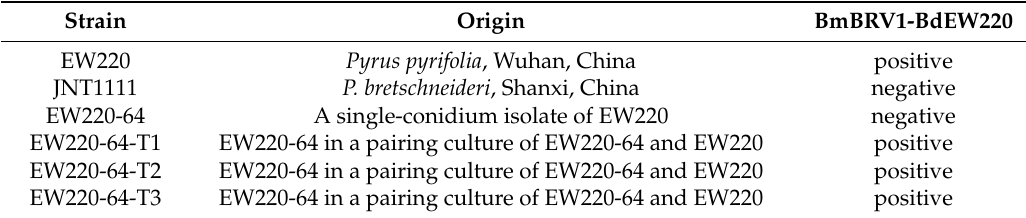
Table 1. Origin of the strains of Botryosphaeria dothidea used in this